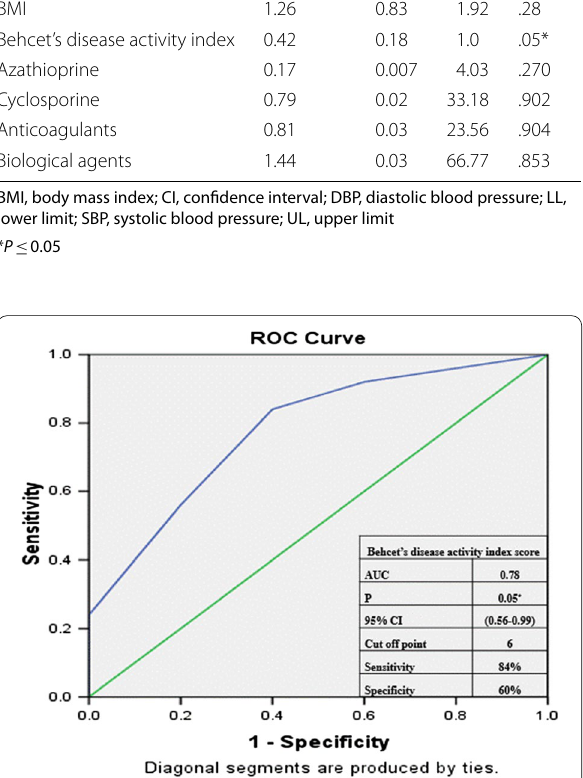
Fig. 2 Receiver operating characteristic (ROC) curve for Behcet’s disease activity index score as a predictor of abnormal cardiac MRI (n 30) =